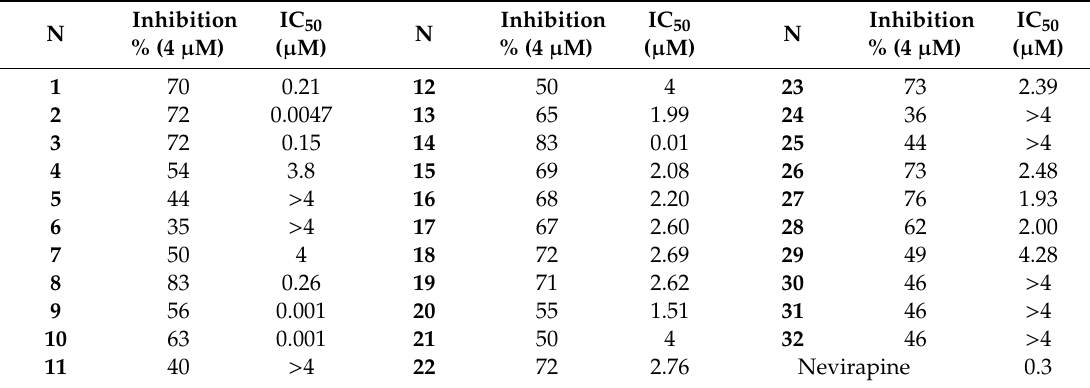
Table 4. HIV-1 RT inhibitory